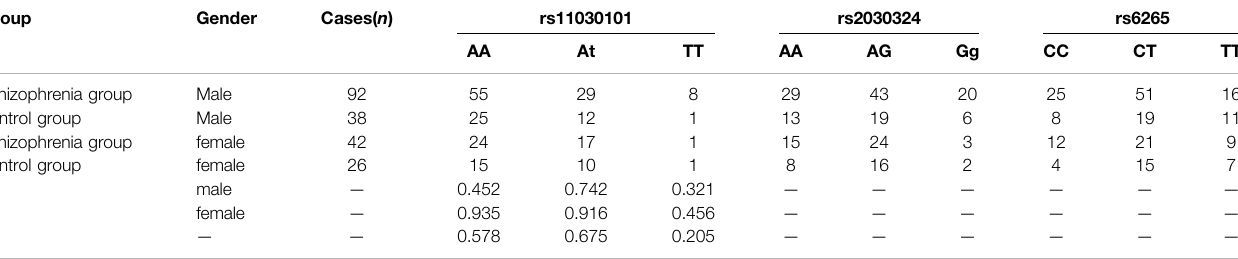
TABLE 3 | Comparison of BDNF rs11030101, rs2030324, and rs6265 genotype frequencies between the two groups. Group